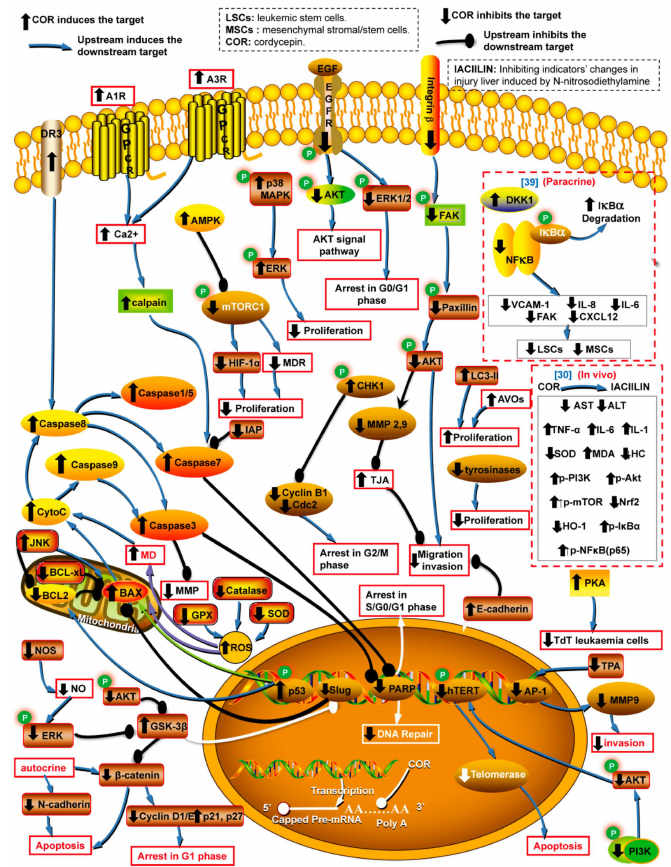
Figure 1. Cellular targets of cancer a ff ected by cordycepin via various signal pathways. Note: A1R: adenosine A1 receptor. A3R: adenosine A3 receptor. GPCR: G protein-coupled receptor. TJA: tight junction activity. IL: interleukin. SOD: Superoxide Dismutase. NOS:nitric oxide synthase. CHK1: Checkpoint kinase 1. GPX: Glutathione peroxidase. EGFR: epidermal growth factor receptor.